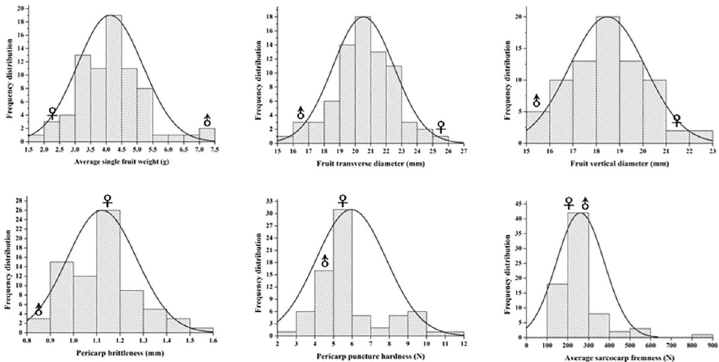
Fig 1. Phenotypic distribution of hawthorn hybrid population crossed from ‘Shandongdamianqiu’ and ‘Xinbinruanzi’. “Shandongdamianqiu” and “Xinbinruanzi’.